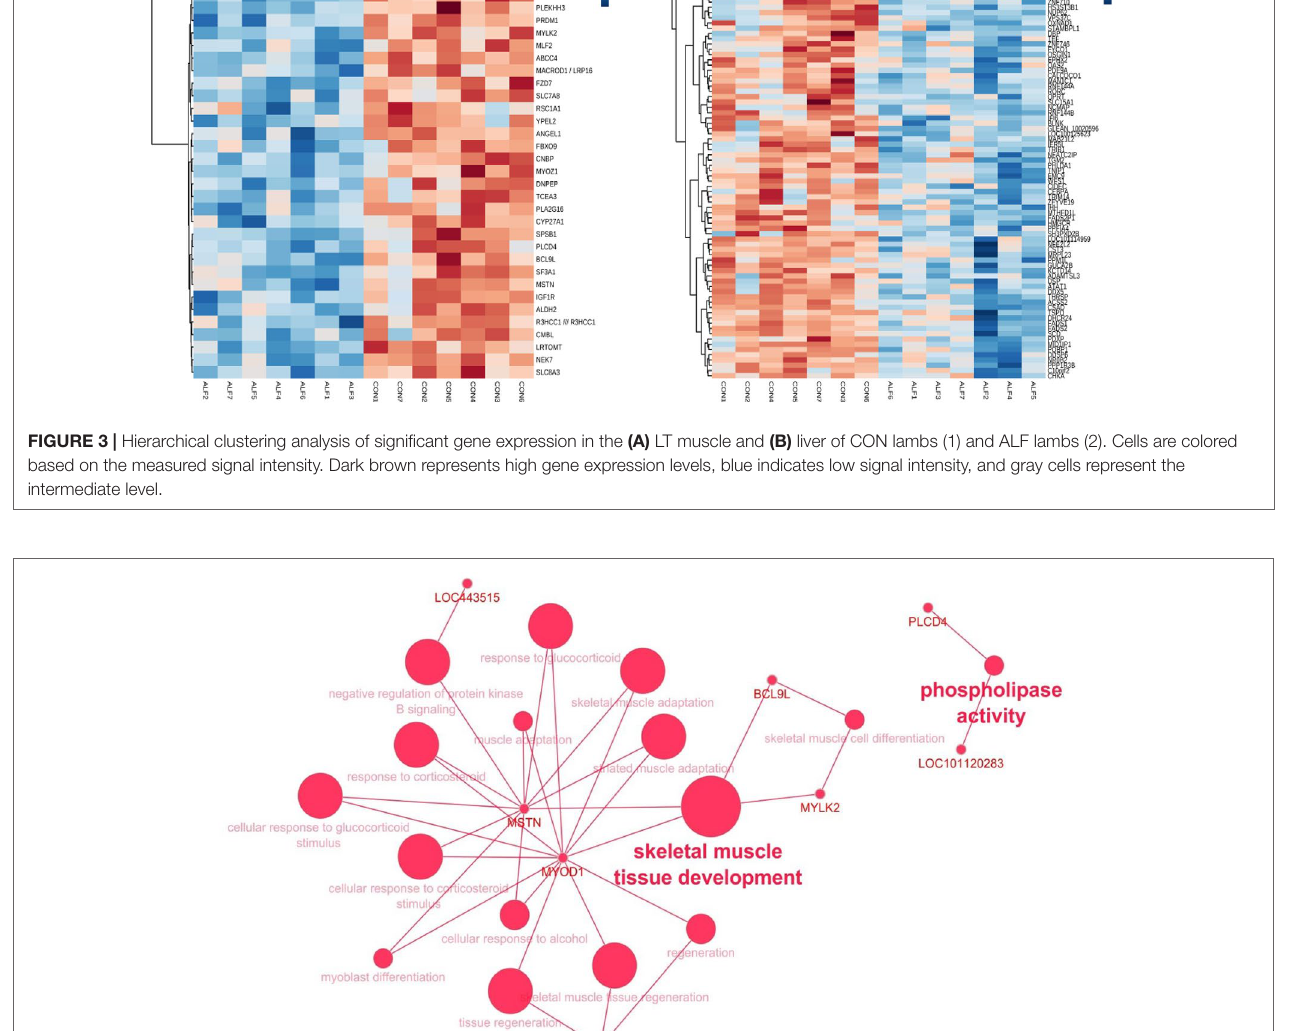
Frontiers in Genetics |